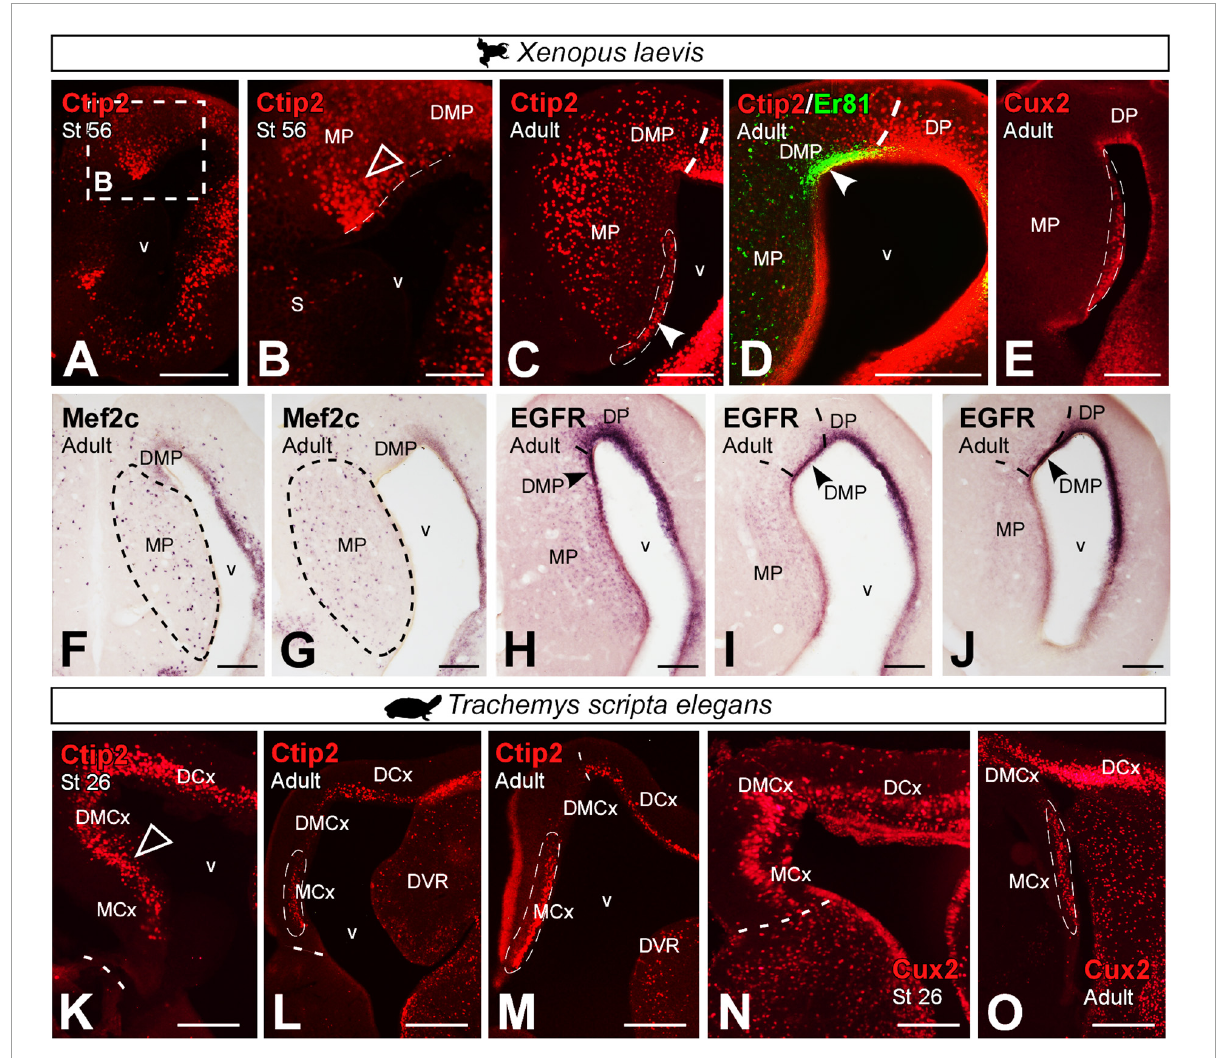
FIGURE11 Photomicrographs of transverse sections through the developing and adult telencephalon of Xenopus laevis (A–J) and Trachemys scripta elegans (K–O) . Ventricular expression is detected in the MP (filled arrowheads) and mantle (empty arrowheads), in prometamorphic larvae (A,B) of Xenopus and, adult (C) . This localization is confirmed by the combination of Ctip2 with Er81, detected in the DMP (D) . Expression of Cux2 (E) , Mef2c (F,G) and EGFR (H–J) are localized in adult X. laevis in the MP region. Ctip2 expression in developing T. scripta is observed in MCx and in DMCx (K) , whereas in the adult was observed mainly in the MCx (L,M) , as well as Cux2 in developing (N) and in adults (O) . In each panel, the developmental stage and the color code for the used markers are indicated. Filled arrowheads point to ventricle-expressing cells and empty arrowheads to mantle-expressing cells. Scale bar in panels (A,C–O) = 200 µ m and (B) = 100 µ m. See the abbreviation